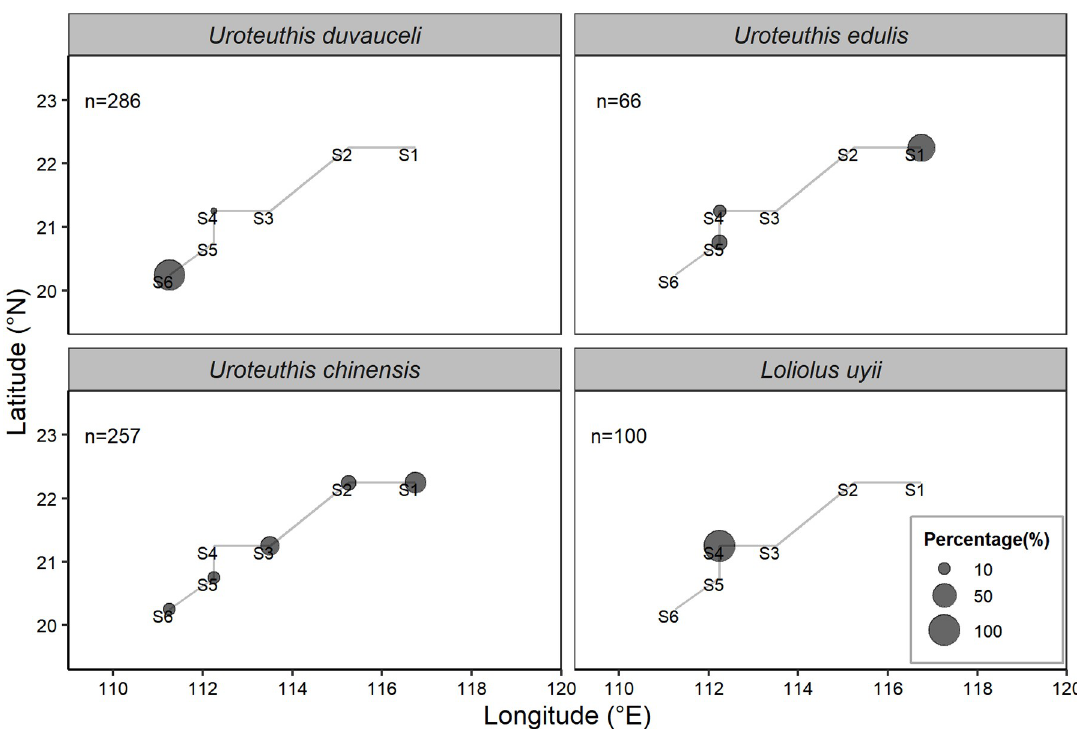
Fig 4. Percentage of specimens collected by sampling station for Uroteuthis duvaucelii , Uroteuthis edulis , Loliolus uyii , Uroteuthis chinensis . S1, S2, ... .S6 correspond to the stations in Fig 1. The size of grey circle represents the percentage of specimens collected at the station.